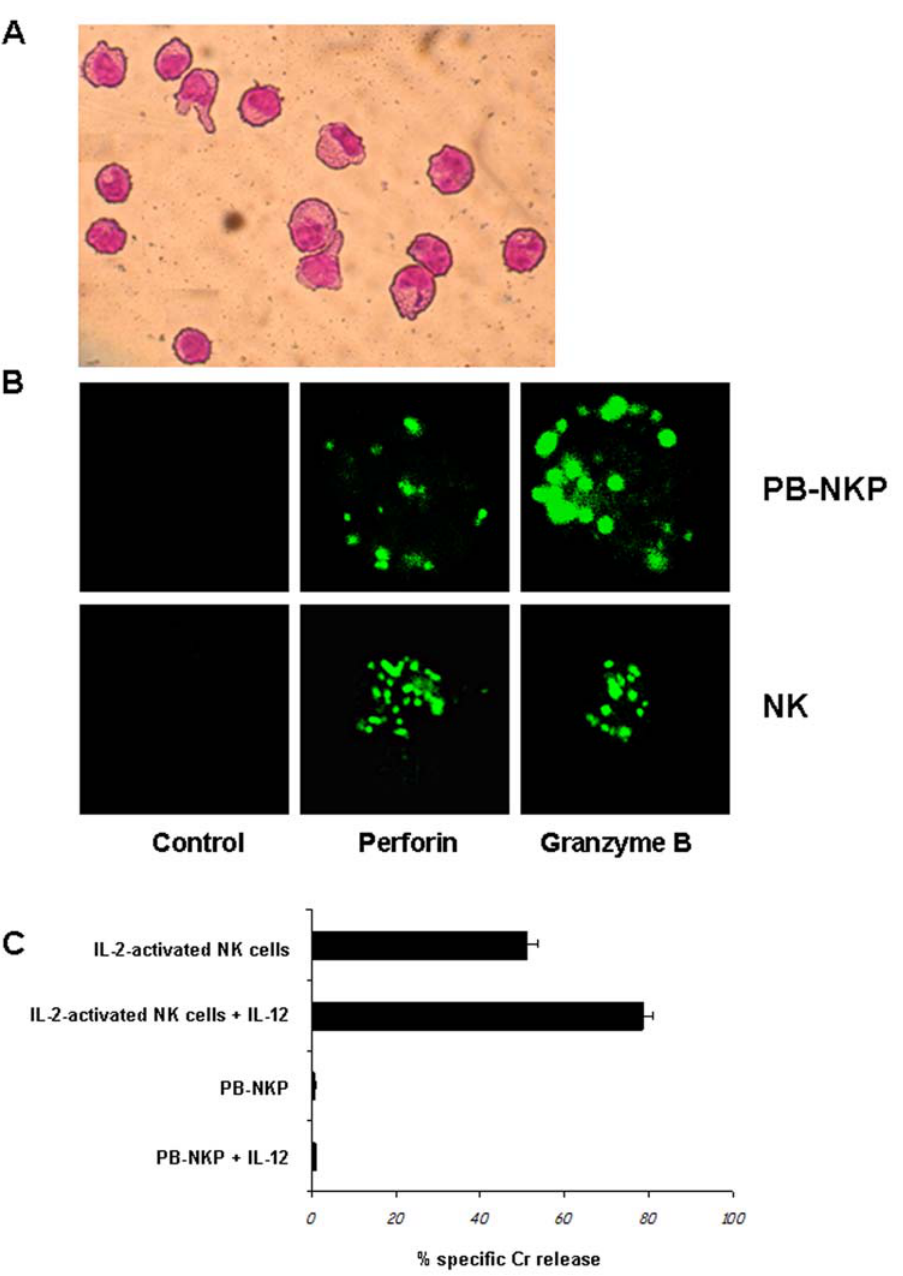
Figure 3. Autonomous NK commitment of PB-HP: morphology and expression of cytolytic granules. (A) Ral 555 staining on 3-weeks-old PB-HP cultured in in STEM a A medium supplemented with 100 ng/ml of FL and SCF. PB-NKP exhibit a lymphoid morphology. (B) Intracytoplasmic expression of perforin and granzyme B in PB-NKP and in PB activated conventional NK cells was analyzed by confocal microscopy. Both cell types were fixed, permeabilized, and stained for perforin and granzyme B. As negative controls, cells were incubated with mouse IgG, and the second reagent. (C) Analysis of the cytolytic activity of freshly purified NK cells from healthy donors (open boxes) and from PB-NKP (grey boxes) against 51 Cr- labelled K562 cells. NK cell effectors, treated or not for 18 hours with IL-12 (5 ng/ml), were assayed in a 4-h 51 Cr-release assay against K562 cells in a dilution of E/T cell ratios (10:1) in duplicate wells. Data are representative of three experiments performed.